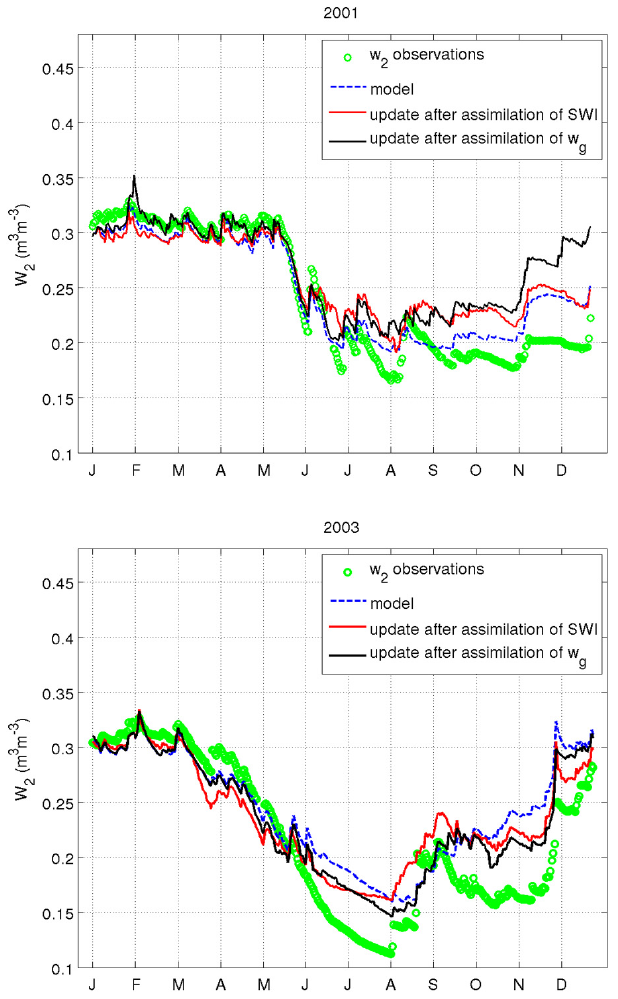
Table 6. Statistics of simulated and updated CO 2 fluxes (mi-